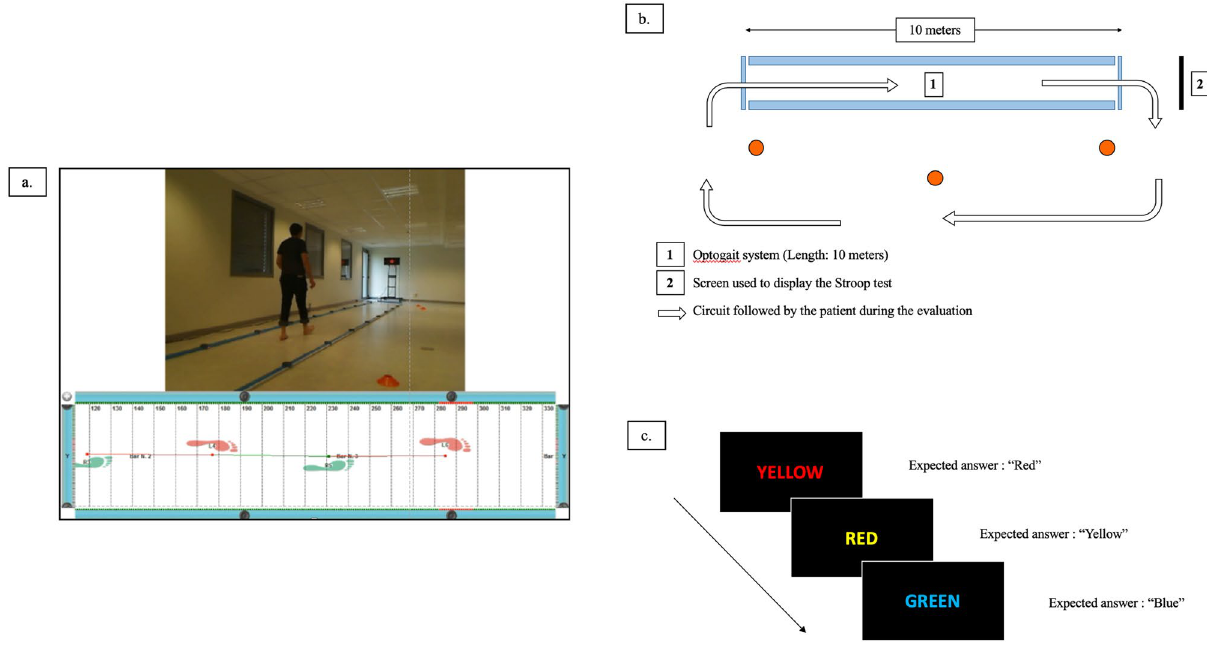
Figure 4. Overground gait and stride time variability assessment experimental setting. ( a ) Picture of the experimental setting. ( b ) Schematic representation of the oval gait circuit (outward in the 10-m long corridor delineated by the Optogait system, return outside of the corridor). Stroop test was displayed on a black background screen installed at the end of the corridor. ( c ) Schematic representation of the visuo-verbal Stroop test. Patients were instructed to name the words font color and to inhibit reading the word (Correct answers here: “red” then “yellow” then “blue”). Words were presented one by one, and the evaluator skipped manually to the next one after the subject gave an oral